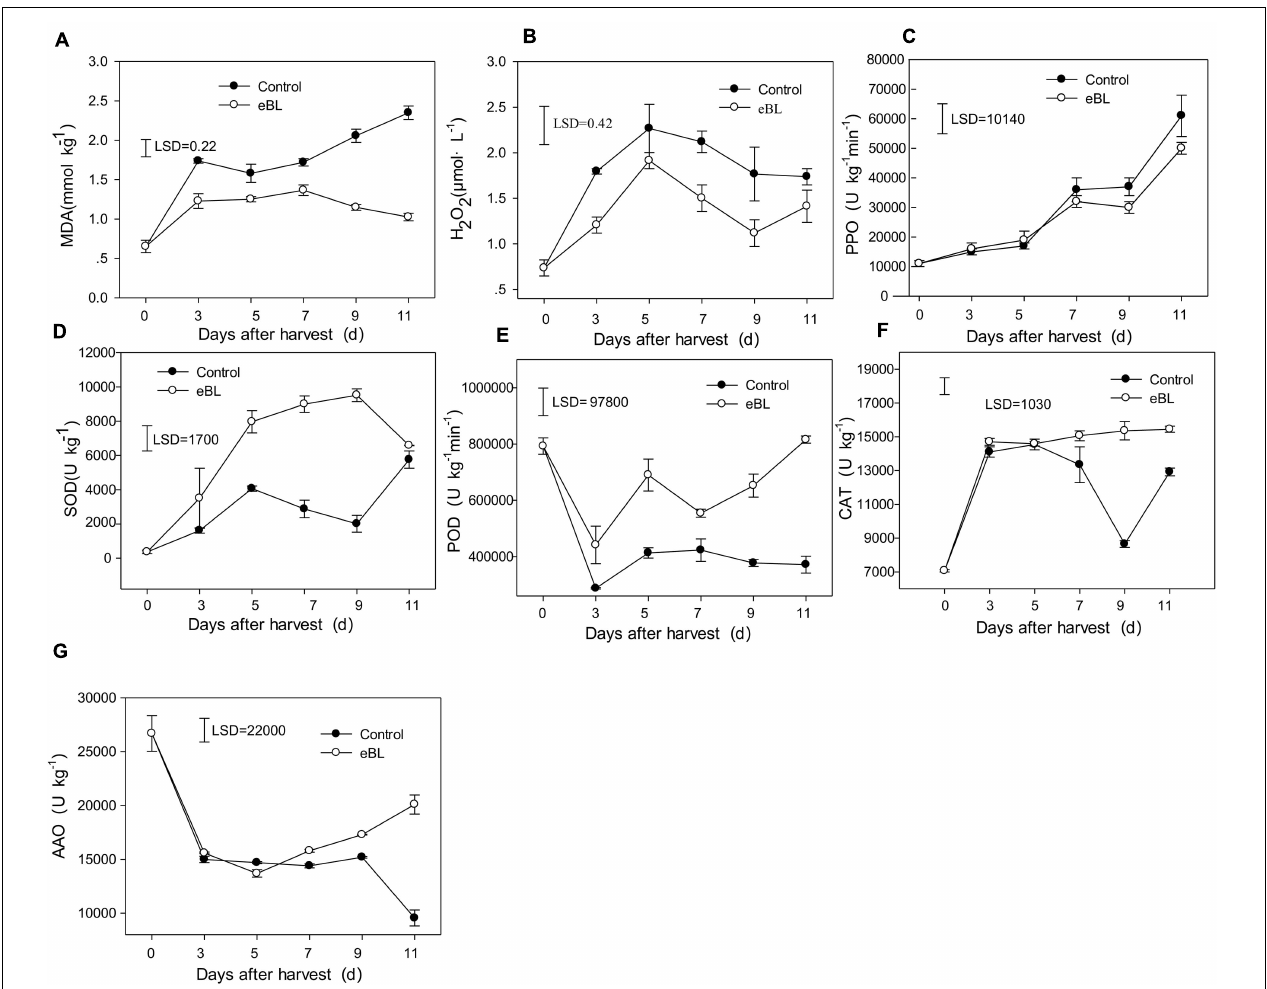
FIGURE 4 | Effects of eBL treatment on the content of reactive oxygen species and antioxidant-related enzyme activities. (A) The content of MDA; (B) the content of H 2 O 2 ; (C) PPO activity; (D) SOD activity; (E) POD activity; (F) CAT activity; (G) AAO activity. Least significant differences (LSDs) were calculated to compare significant effects at the 5% level. Each data point represents the mean ± S.E. ( n =